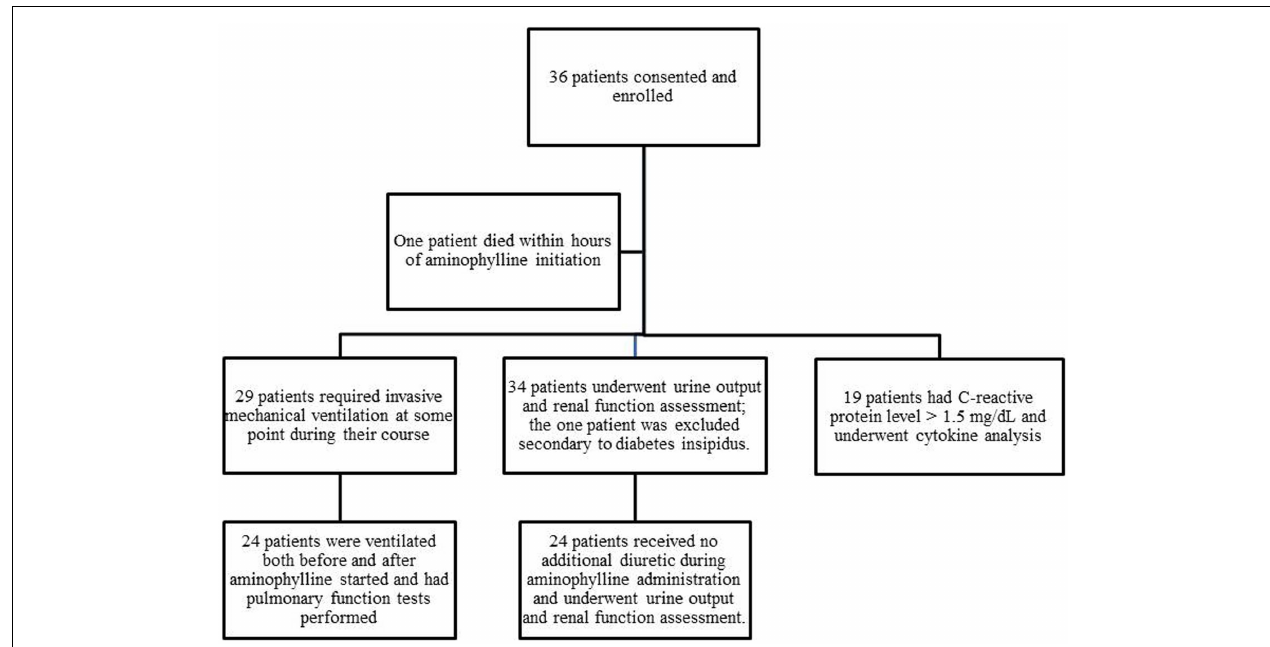
FIGURE 2 | Patients enrolled and assessed in various components of the study .The figure depicts the total enrollment of patients into the trial and the number that underwent the various components of